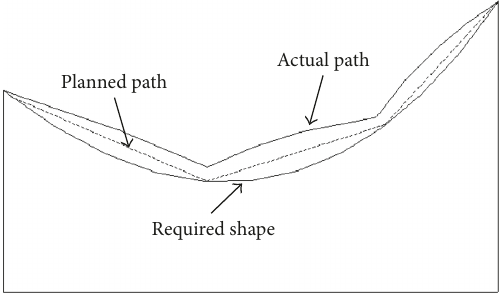
Figure 3: Deviation between planned path and actual